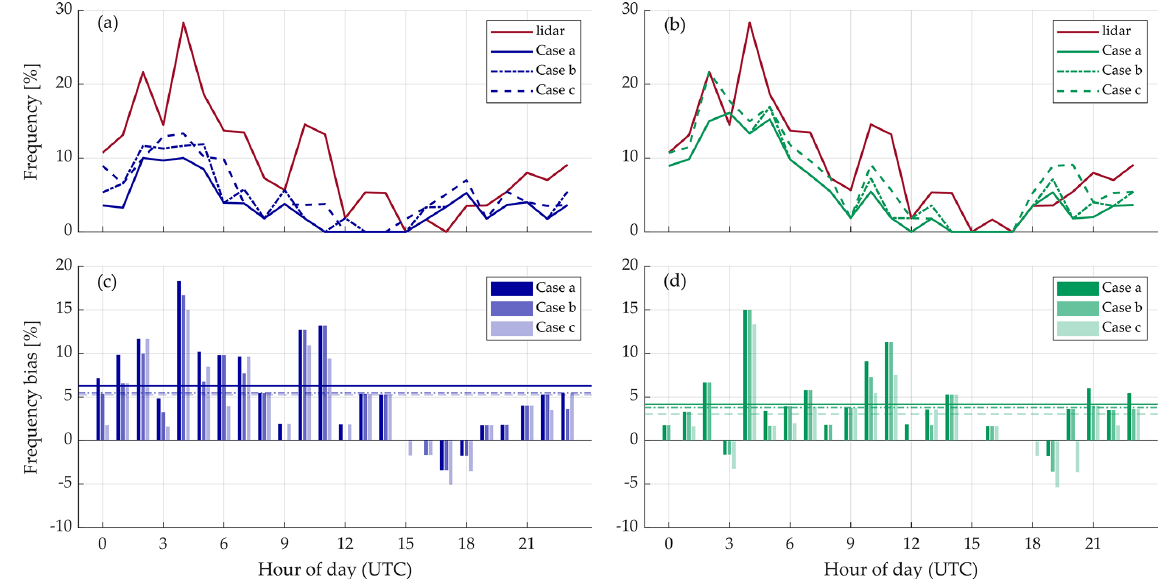
Figure 13. (a, b) Hourly frequency of LLJ occurrence according to lidar measurements and numerical models for the three presented cases. (c, d) Hourly frequency bias. The overall mean absolute bias for the three cases is indicated by the continuous (case a), dashed-dotted (case b), and dashed (case c) lines. Left panels (a, c) for ERA5 and right panels (b, d) for NEWA.